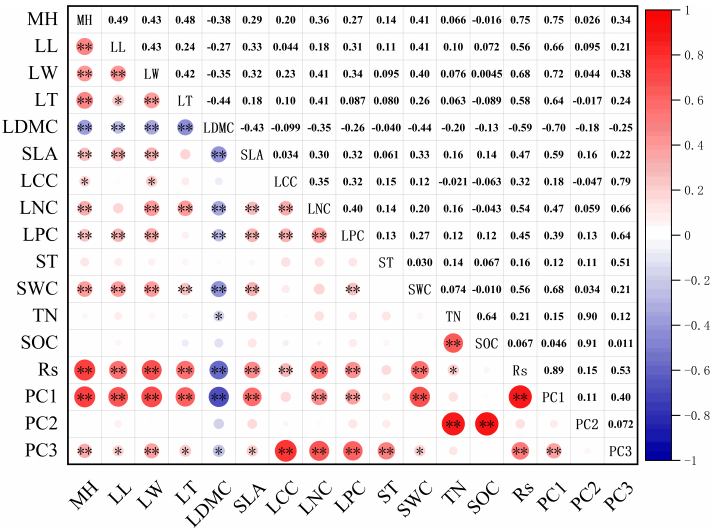
Figure 3. Correlation analysis between plant functional traits, environmental factors, and principal components (Legend: p ≤ 0.05 *, p ≤ 0.01